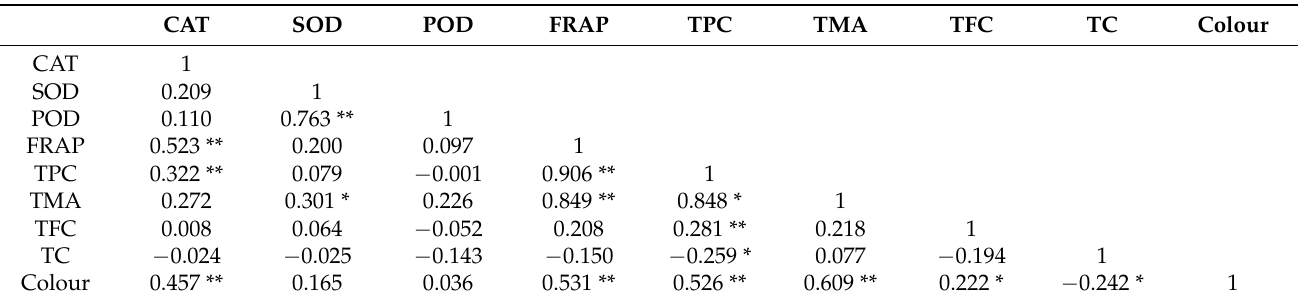
Table 4. Pearson correlation coefficients between the enzymatic activity, phytochemicals and colour of pepper fruits.